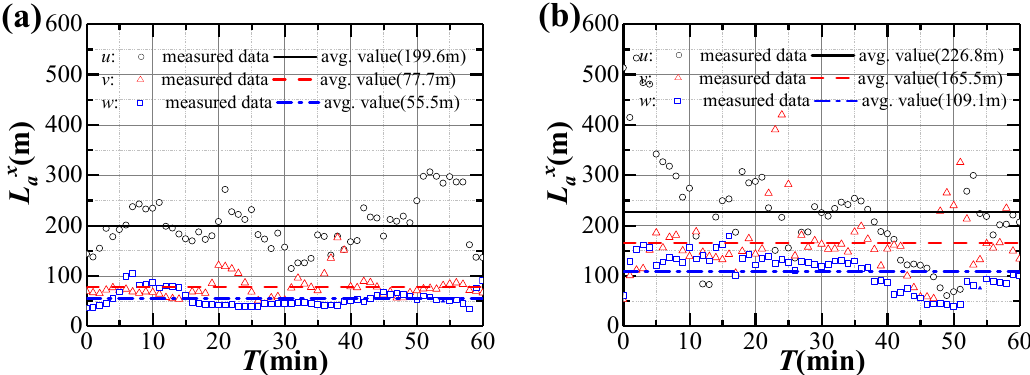
Figure 7. Variation of integral length scales during strong winds: ( a ) Typhoon Bailu; ( b ) Strong monsoon event.